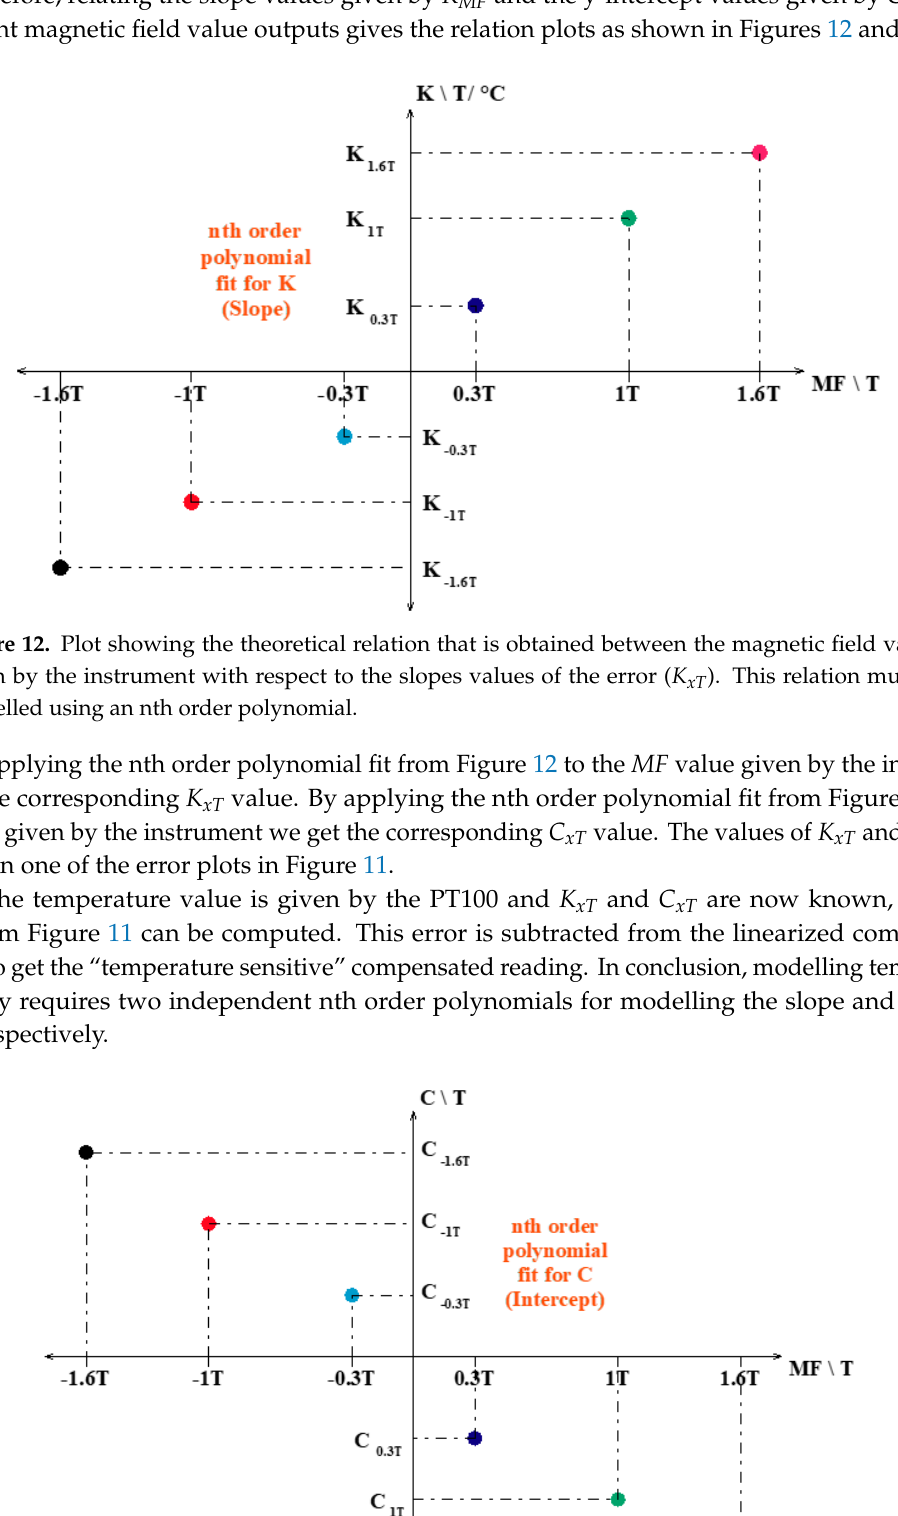
Figure 11. Error plot extracted from Figure 10 when subtracting the instrument output response from the NMR reading. A set of slope values K MF and intercept values C MF is obtained. Therefore, relating the slope values given by K MF and the y-intercept values given by C MF to the instrument magnetic field value outputs gives the relation plots as shown in Figures 12 and 13.